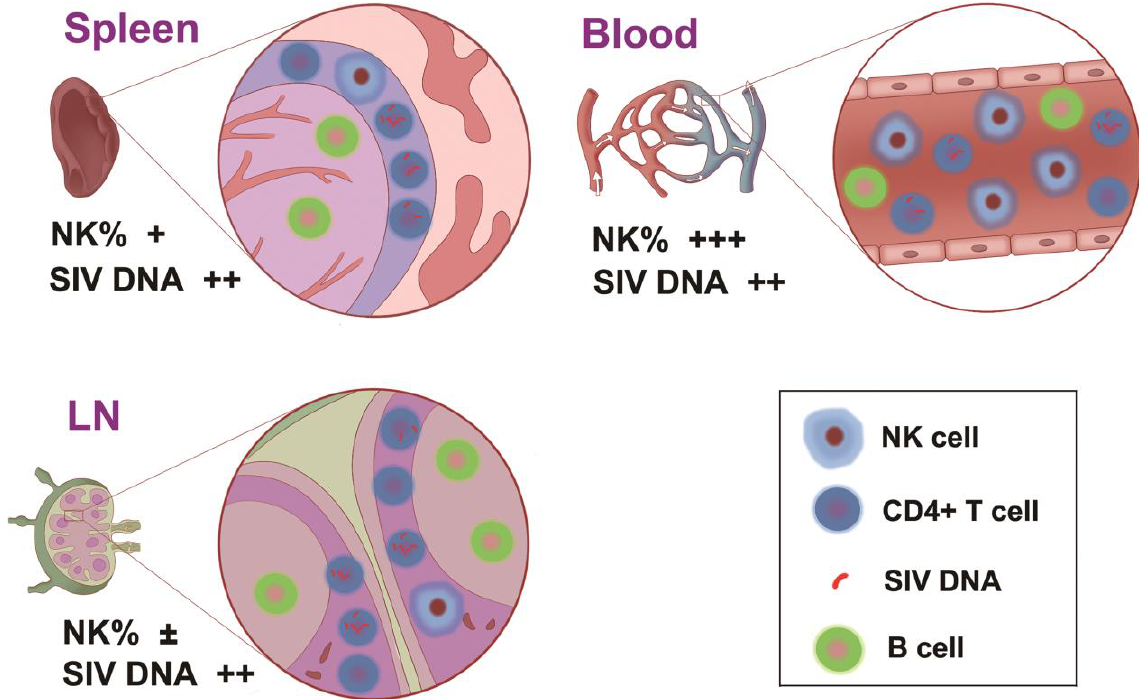
Figure 6. The diagram of NK cells and HLADR - CD4 + T cells in the blood, LNs, and spleen.